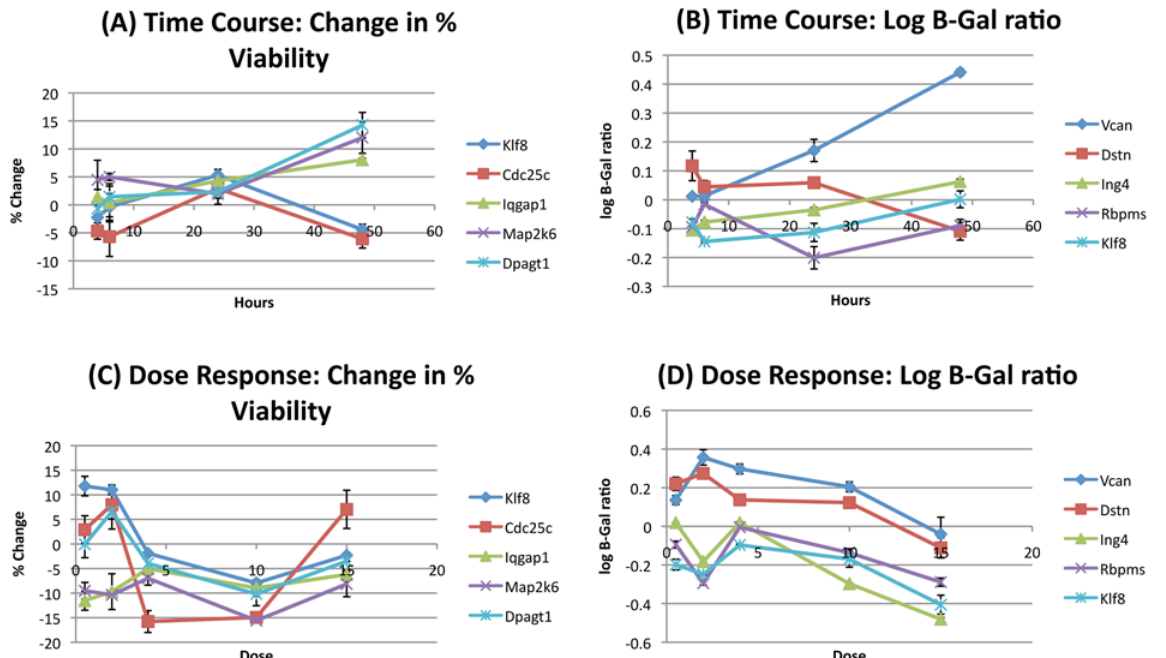
Fig 2. Validation assays. (A) Change in % viability over time for selected clones. (B) Change in gene expression over time for selected clones. (C) Change in % viability due to radiation dose for selected clones. (D) Change in gene expression due to radiation dose for selected clones. Error bars indicate